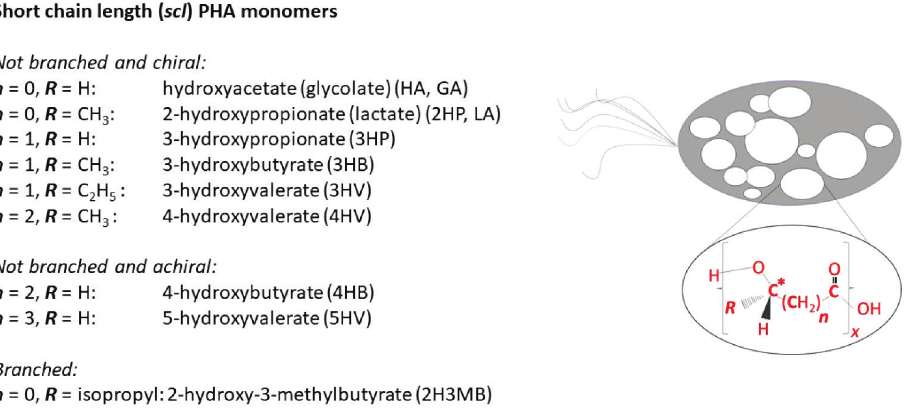
Fig. 2 – Monomers of scl-PHA in PHA polyesters discussed in the present